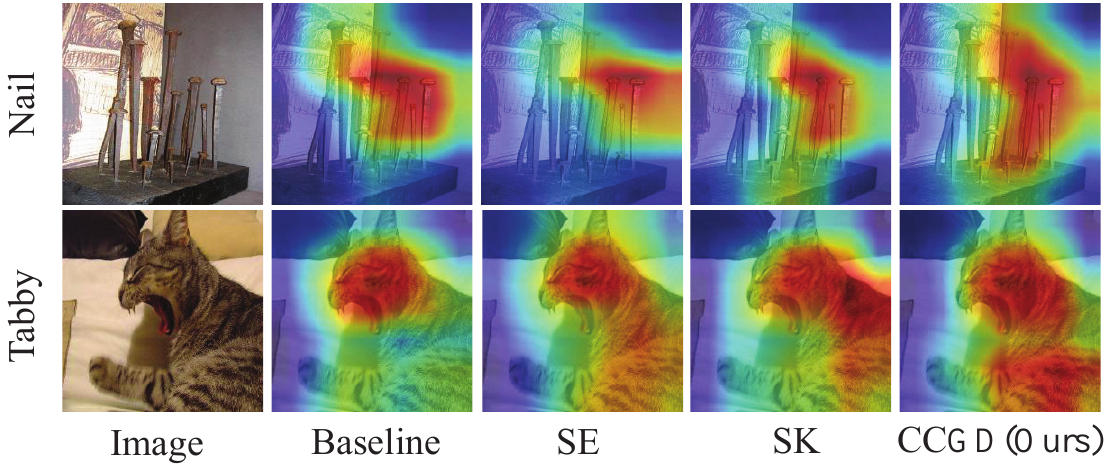
Figure 1. Heatmaps for different learning models using Grad-CAM [12]. All the selected models were based on ResNet50 [13] and trained on ImageNet [14]. It can be seen that CCGD offers more comprehensive region